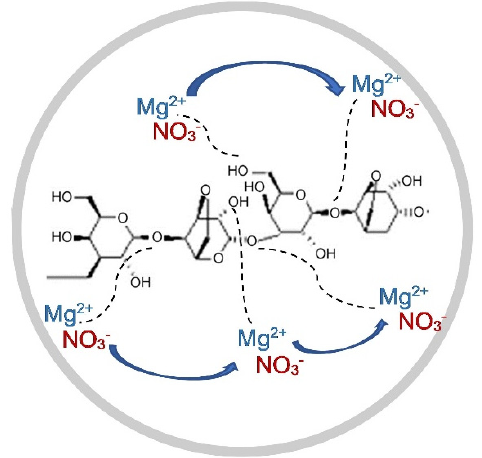
Figure 7. Mechanism of complexation between agarose molecules and Mg(NO 3 ) 2